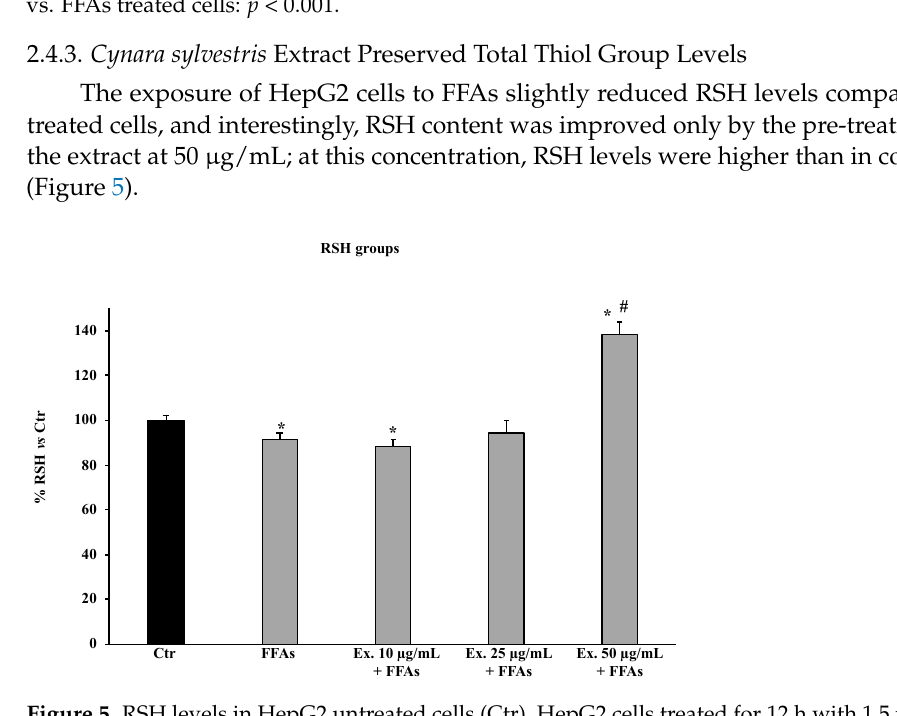
Figure 5. RSH levels in HepG2 untreated cells (Ctr), HepG2 cells treated for 12 h with 1.5 mM FFAs 1, and HepG2 cells pre-treated with the extract (10–25–50 µg/mL) and exposed to FFAs 1. Results are expressed as percentage of total thiol group levels vs. Ctr. Values are the mean ± S.D. of three independent experiments in triplicate. * Significant vs. untreated control cells: p < 0.001. # Significant vs. FFAs treated cells: p < 0.001.